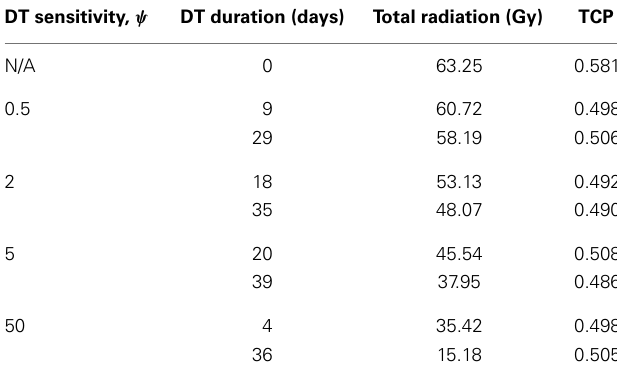
Table 2 |A selection of head and neck cancer tumor treatment parameters resulting inTCP ≈